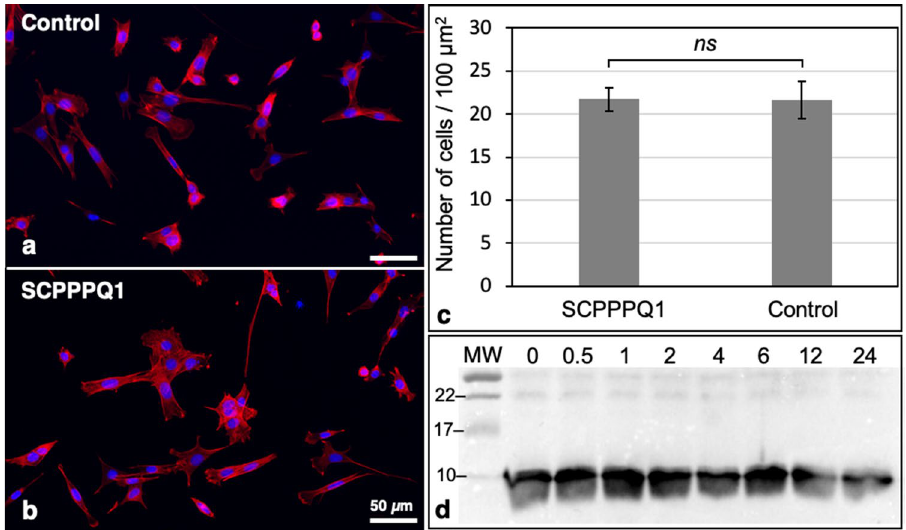
Figure 7. Evaluation of the effect of SCPPPQ1 on LS8 cells. Ameloblast-like LS8 cells were seeded on coverslips, grown overnight, and incubated for 24 h in ( a ) the absence (control) or ( b ) presence of SCPPPQ1 (20 µM) in the media. ( a , b ) Cells were fixed and stained with rhodamine phalloidin (red) and Hoechst (blue), and ( c ) images analyzed to assess cell density. Data represent the means ± SD (n = 3). ns non-significant. ( d ) The media of cells incubated with SCPPPQ1 was sampled over the 24 h incubation period and analyzed by Western blotting to detect SCPPPQ1. Numbers at top indicate the time in hours and molecular weight (MW) markers (kDa) are labeled at